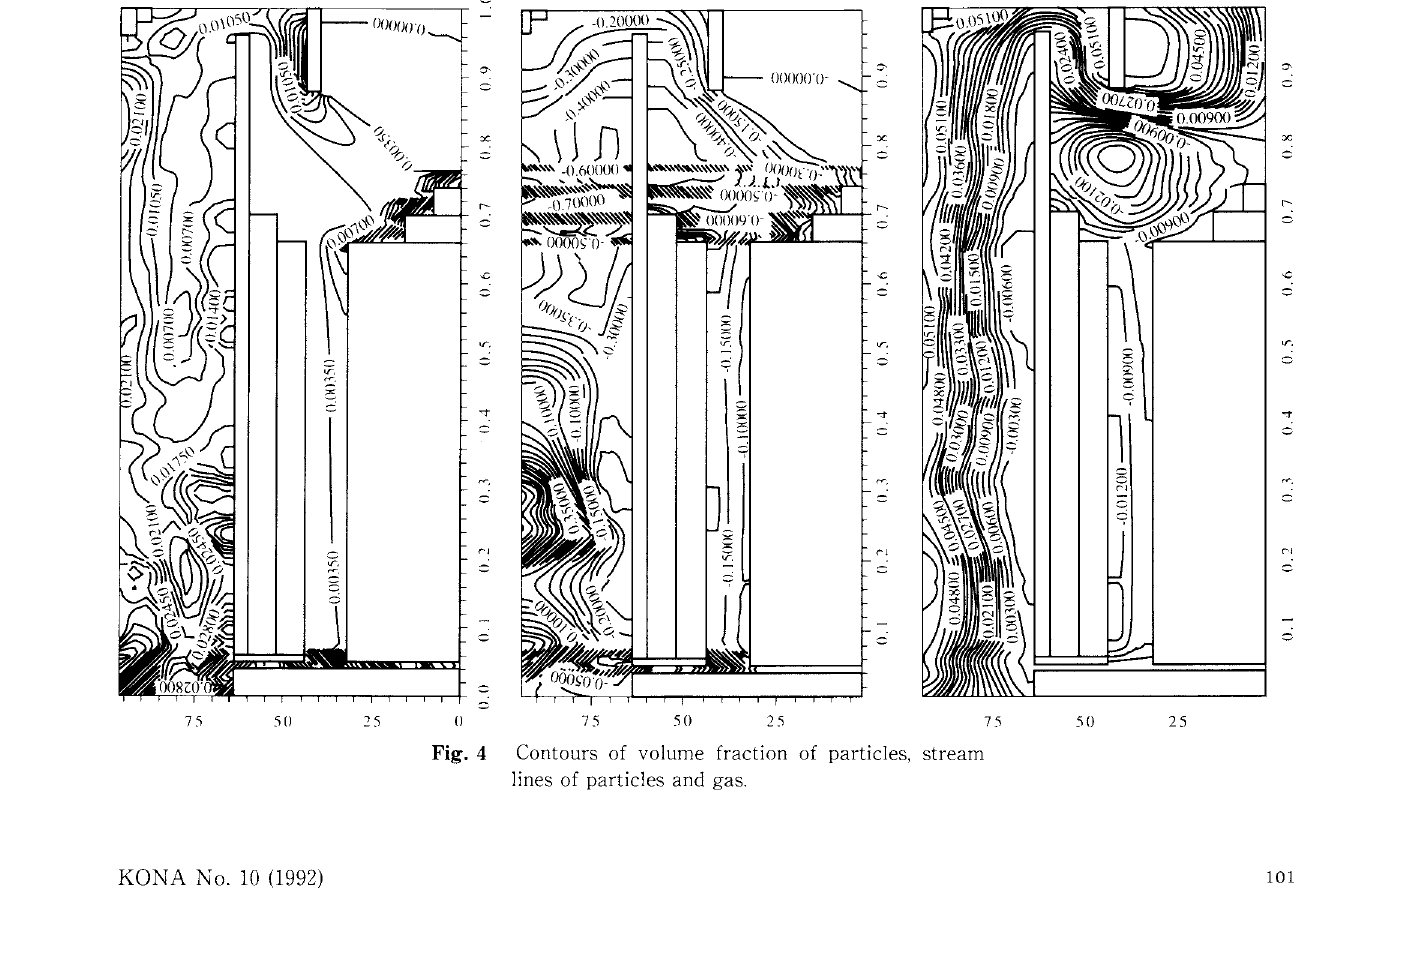
Fig. 4 Contours of volume fraction of particles, stream lines of particles and